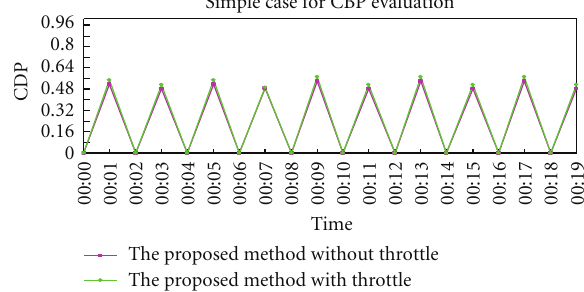
Figure 10: Comparison of CBPs without throttle and with throttle for simple case.